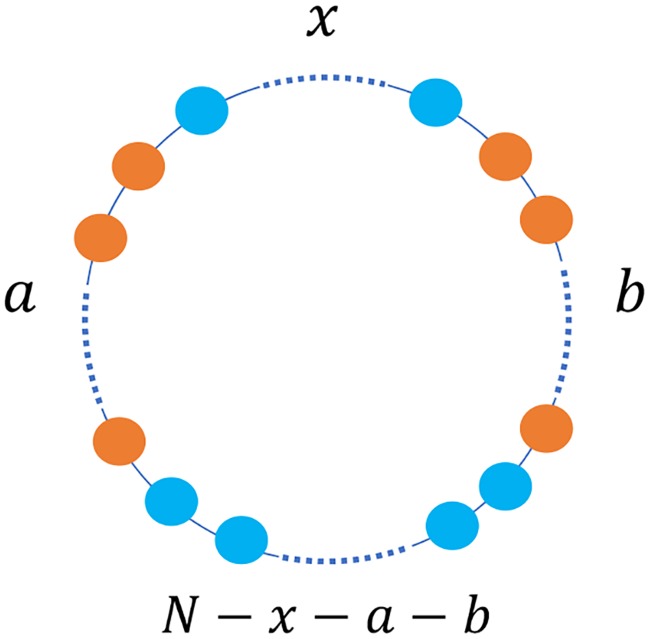
State notation of the configuration in a circle.We assume that there are at most two separated mutant groups. The state is denoted as a triplet (x, a, b). Here x refers to the minimal distance between two mutant groups, a and b represent the group sizes of the smaller group and that of the larger one. The following inequalities holds: a ≤ b and x ≤ N − x − a − b.